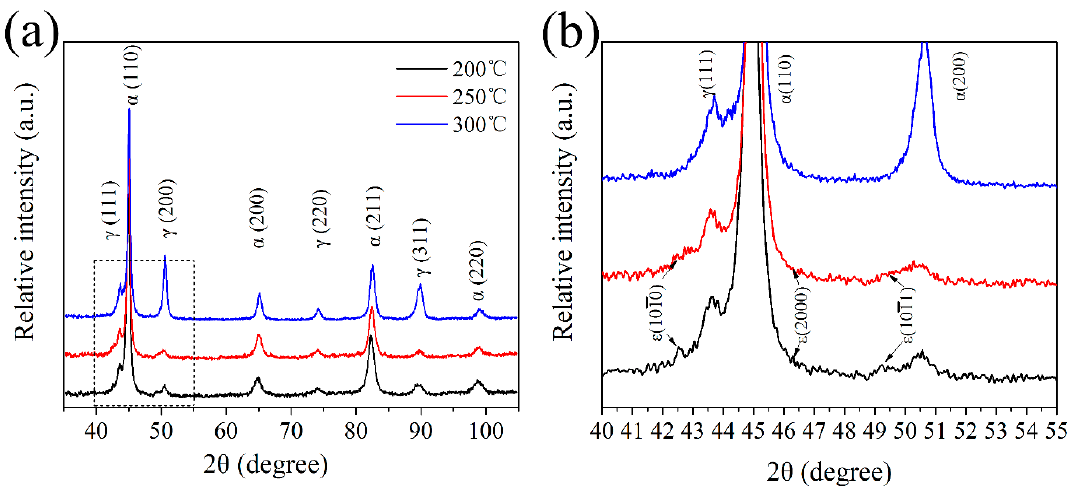
Figure 10. The XRD patterns of the isothermal transformed coatings ( a ), detailed of XRD patterns from 40° to 55° ( b ).